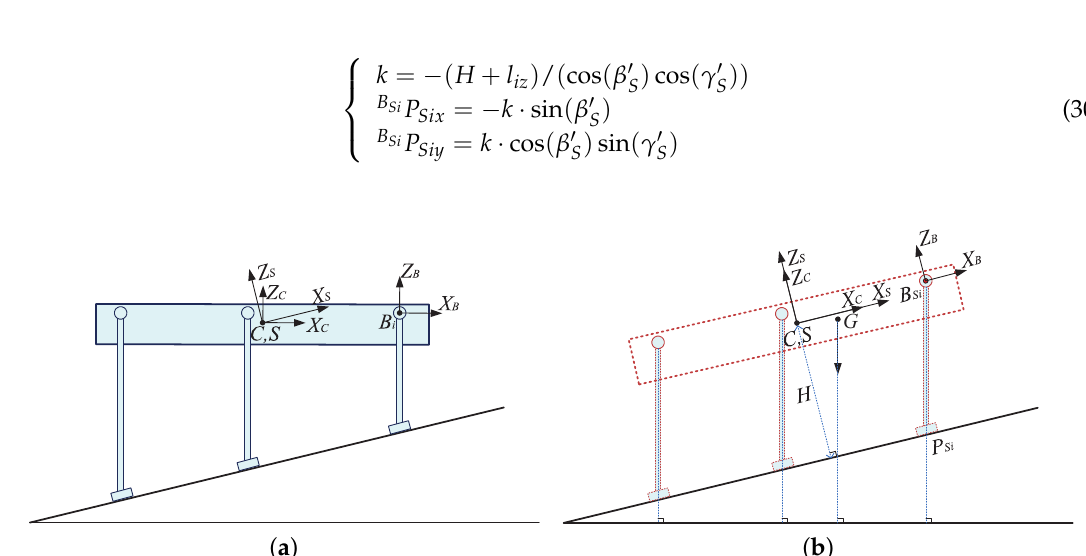
Figure 8. The hypothetical and actual postures of the robot standing still: ( a ) the actual robot posture and ( b ) the hypothetical robot